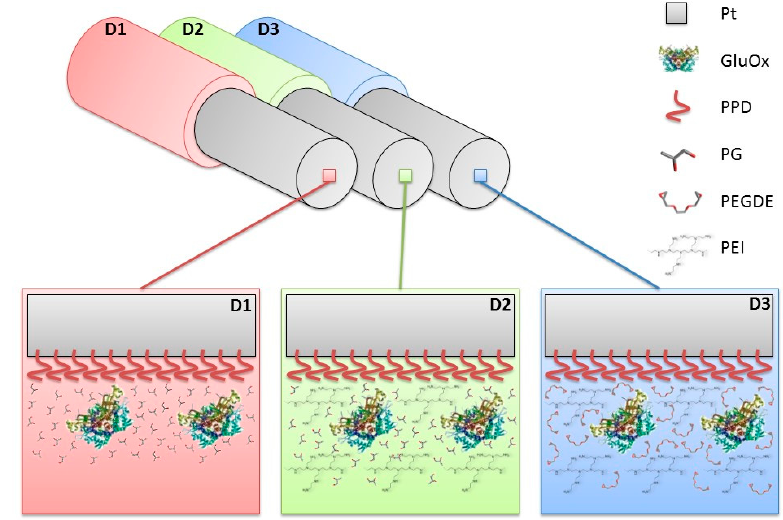
Figure 1. Schematic representation of the main designs of glutamate biosensors characterized in this study.